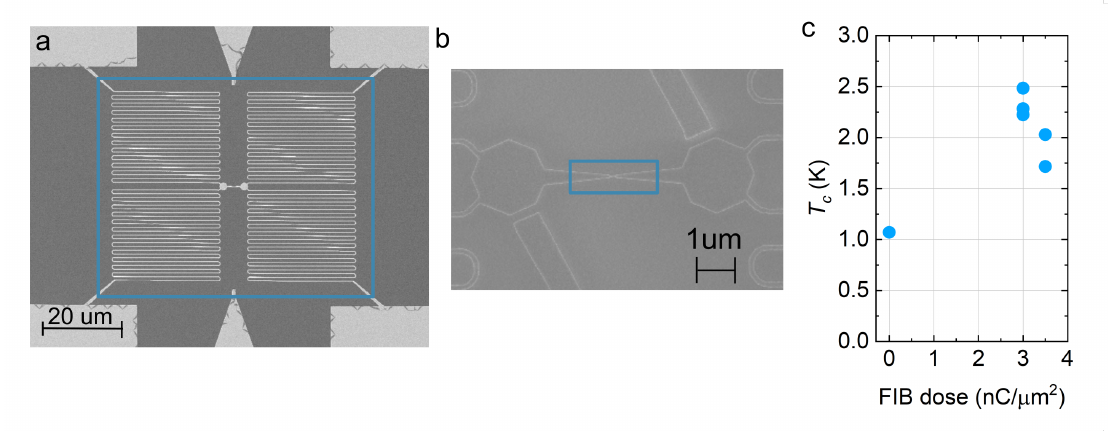
Figure A1. ( a ) Large scale image of a sample. The light blue square indicates the area exposed by gallium FIB. ( b ) Closeup on the sample showing also the area exposed when studying effect of helium FIB (light blue square). ( c ) Critical temperature as a function of helium FIB